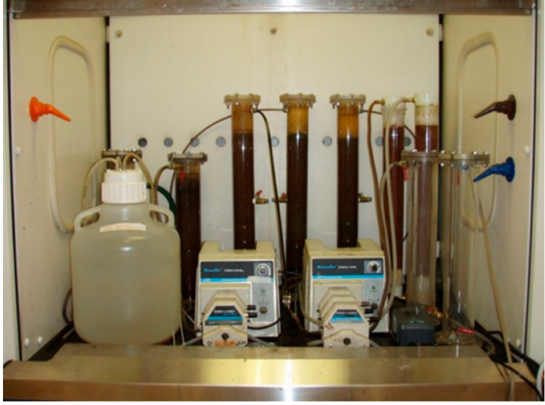
Figure 1. The laboratory facility for the treatment of sucralose production wastewater with recalcitrant organic